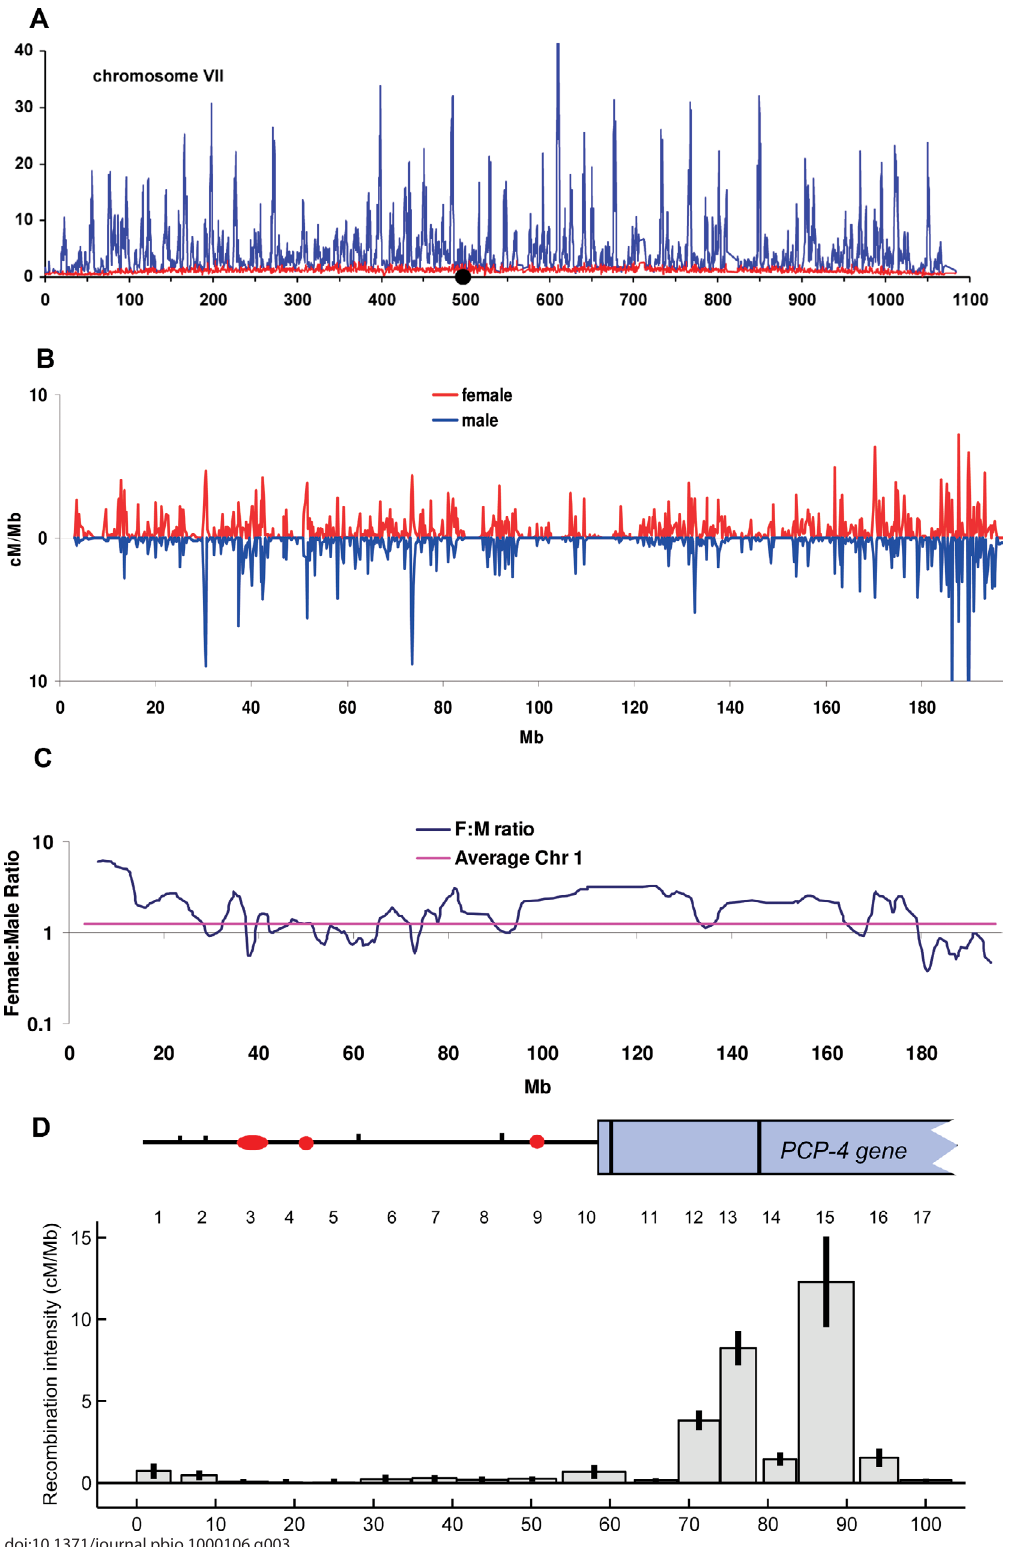
Figure 3. Nonrandom Distributions of Double-Strand Break Hotspots in Yeast and Crossover Hotspots in Mice and Humans (A) illustrates the distribution of double-stand breaks on a single chromosome in yeast [37]. A recent genome-wide crossover map made in a hybrid yeast diploid [38] shows a good, but not perfect, correlation between double-strand breaks and crossover hotspots, suggesting that not all double- strand break hotspots are crossover hotspots. (B) illustrates differences in the distribution of crossovers on Chromosome 1 in male and female meioses [20]. One can see that, in general, the same hotspots are used but that the intensity varies in males and females. This can be clearly seen in (C), where the ratios of crossovers in females to males is plotted across the chromosome. (D) illustrates the punctate distribution of crossovers in a small region of human Chromosome 21 as measured by sperm typing analysis